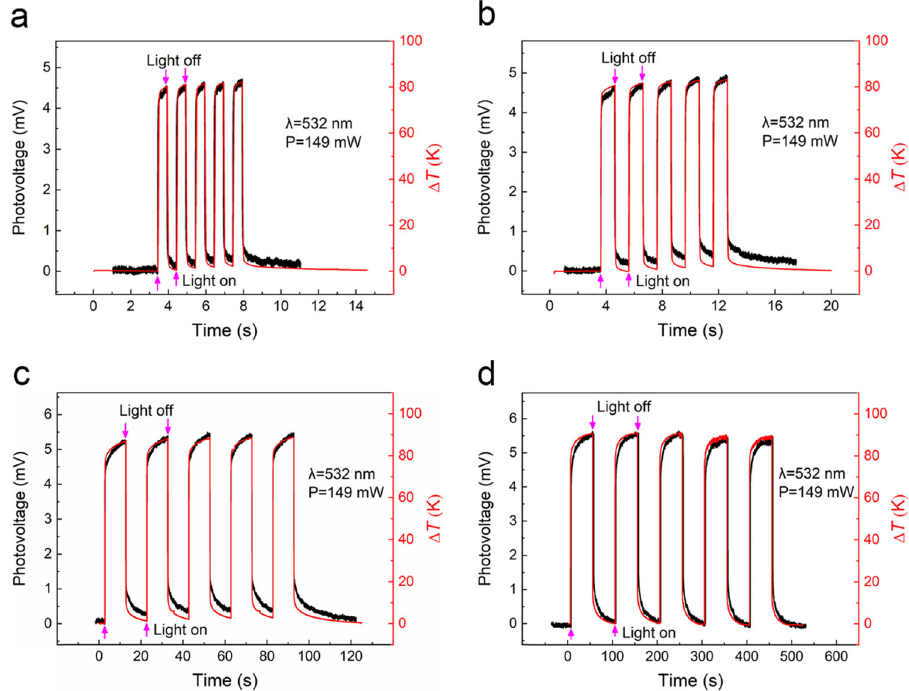
Fig. 5 Comparison of photovoltage – time and Δ T – time curves. a – d Photovoltage – time and Δ T – time curves on the same time axis when the heterojunction of the sample was irradiated by a laser with wavelength of 532 nm and power of 149 mW, and the cycle of the optical shutter switching was set to 1, 2, 20, and 100 s,